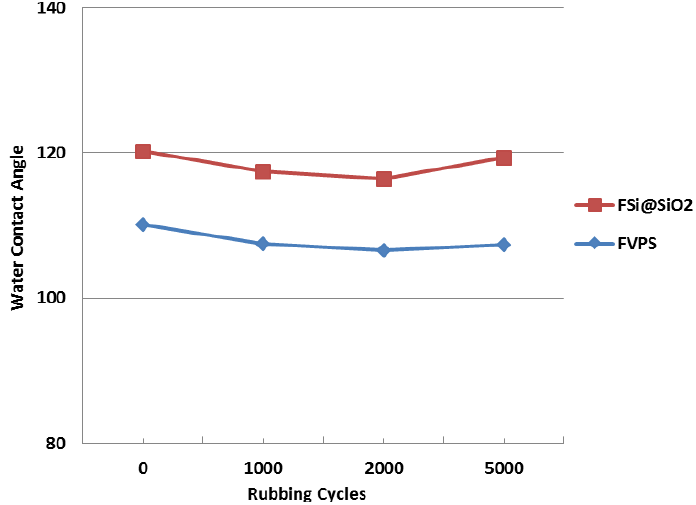
Figure 11. Impact of Rubbing Durability on Water Contact Angles.